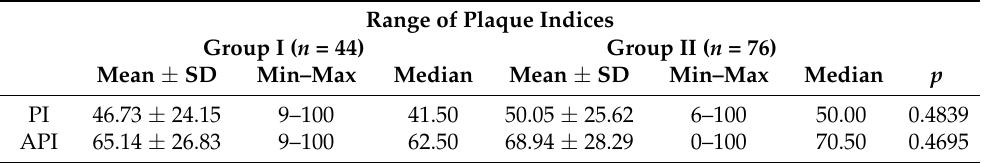
PI: plaque index; API: approximal plaque index; SD: standard